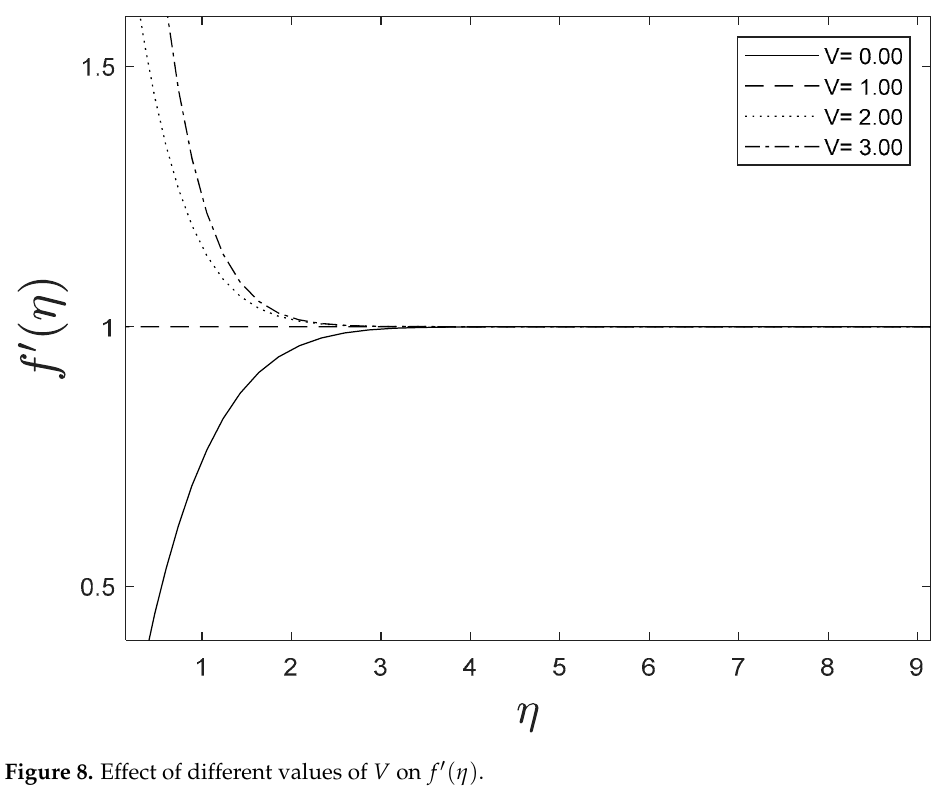
Figure 8. Effect of different values of V on f (cid:48) ( η ) .